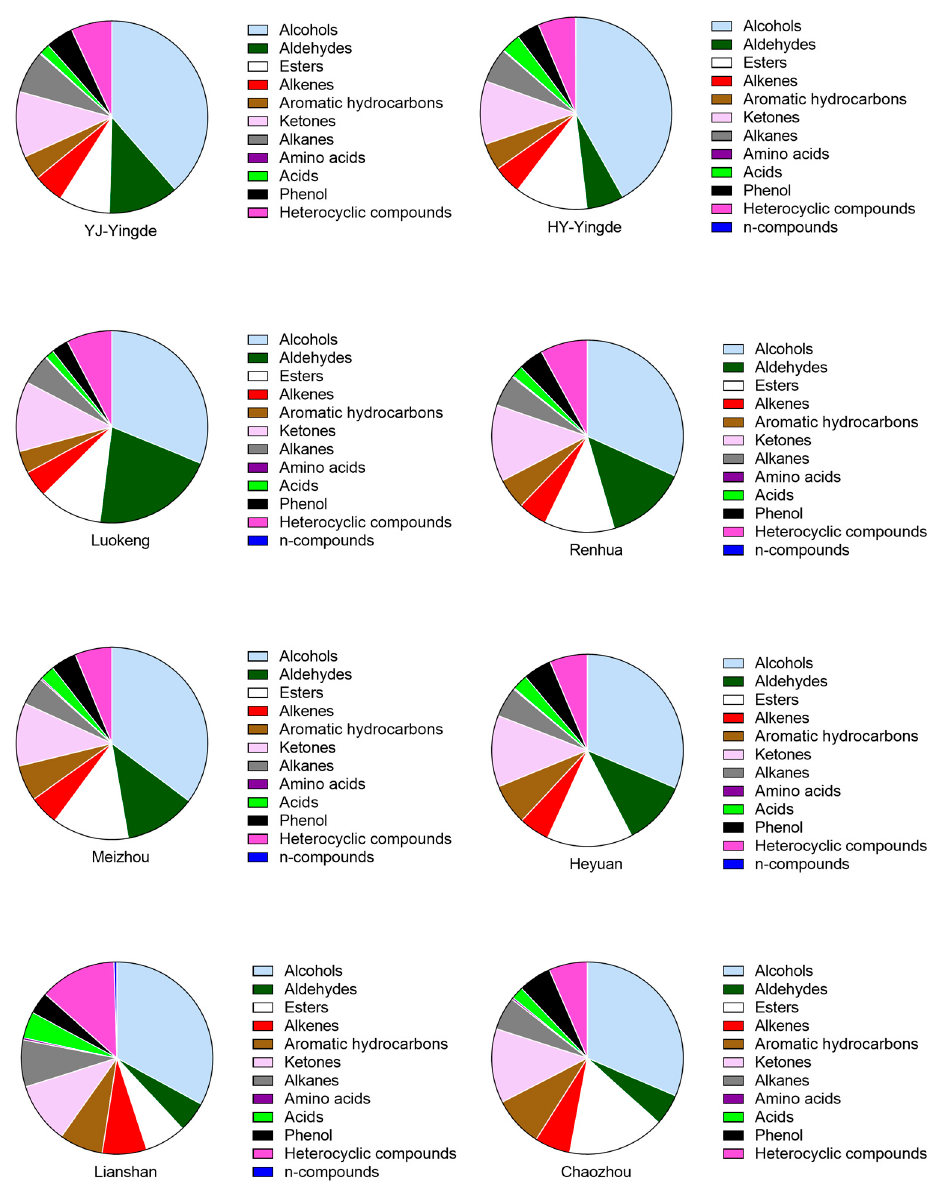
Figure 2. Proportions of the 12 identified groups of VFCs in black tea samples from 7 districts in Guangdong Province .